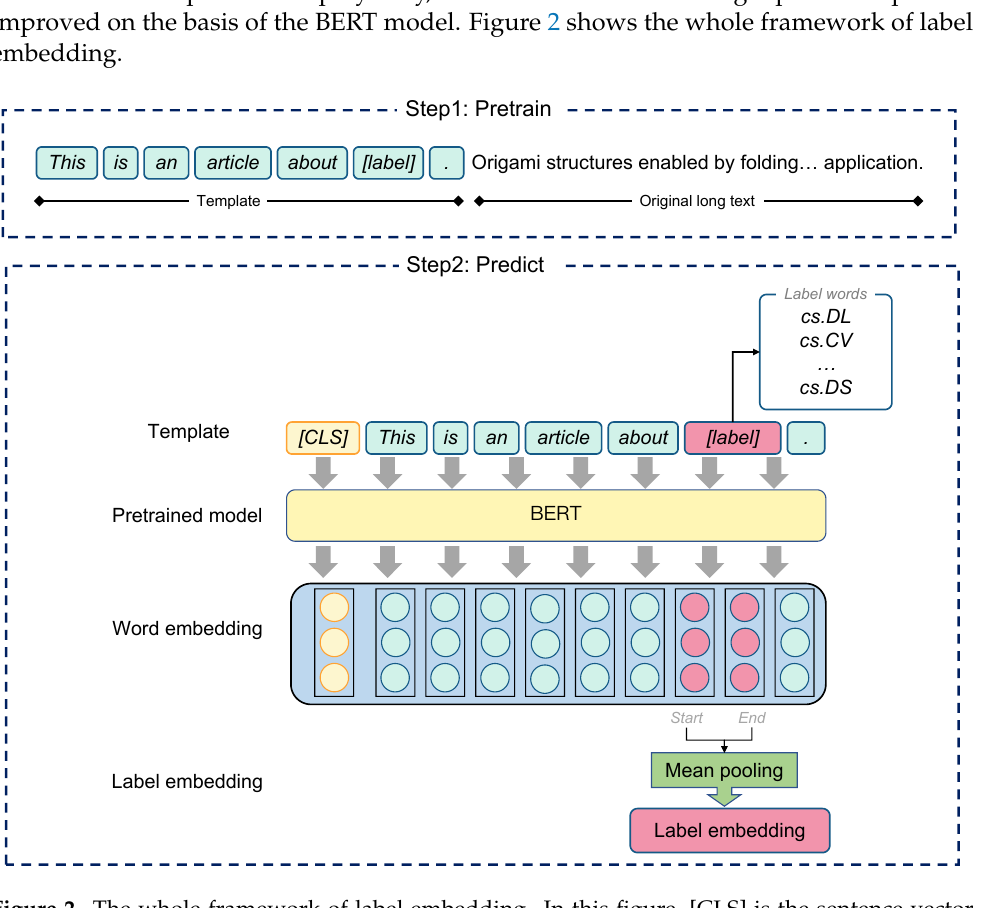
Figure 2. The whole framework of label embedding. In this figure, [CLS] is the sentence vector representation slot, which outputs the sentence vector representation. [label] is the label word filling slot, which fills the label word to associate the label word with the long